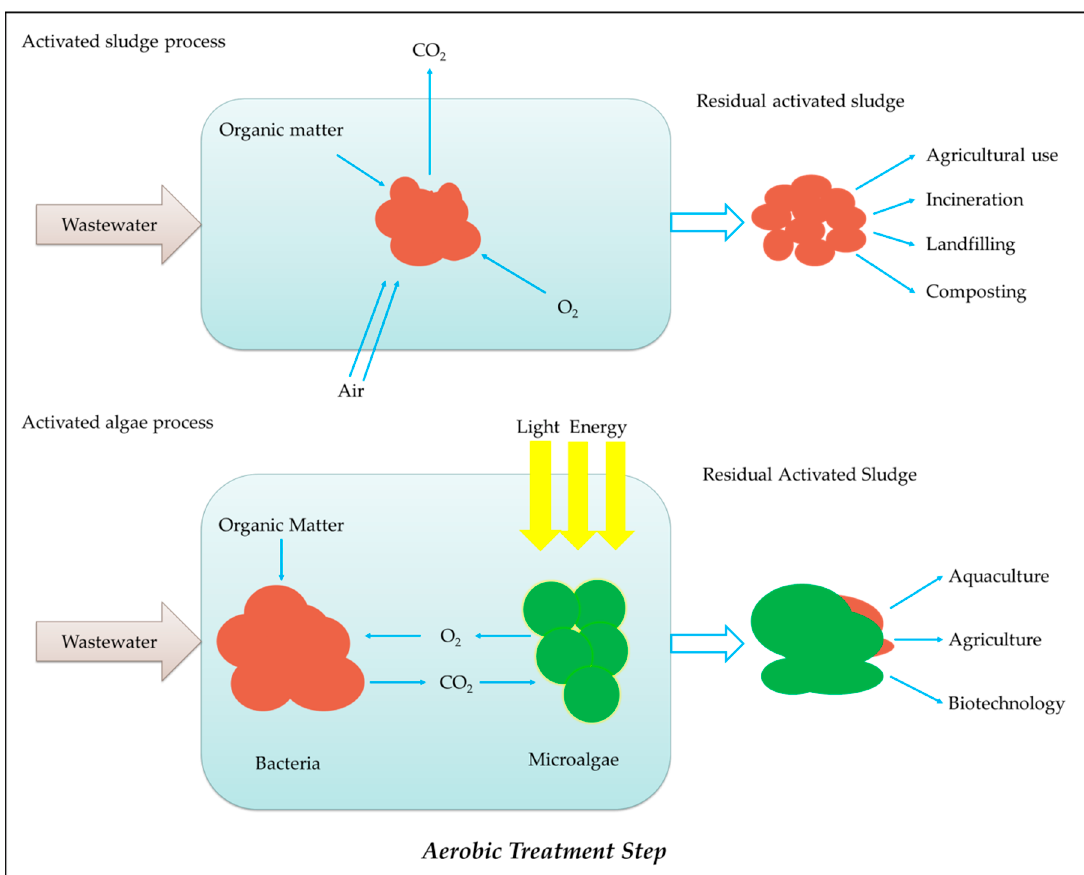
Figure 4. CO 2 savings comparison between activated microalgae and conventional activated sludge processes in aerobic wastewater treatment.